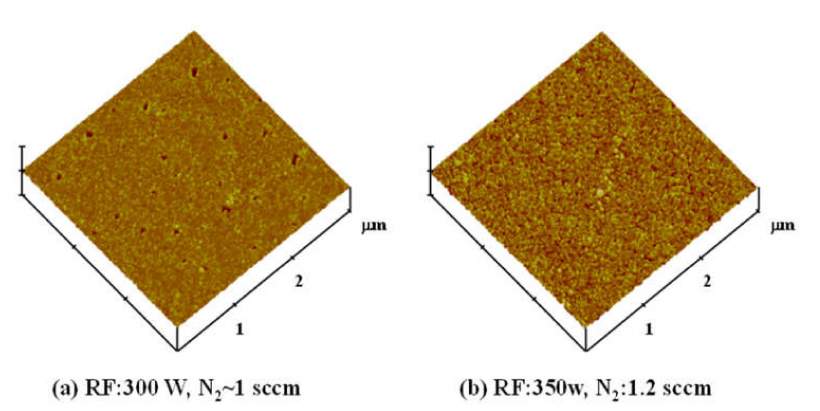
Figure 2. ( a ) Surface morphologies, refractive index, and extinction coefficient of nitrided Si x N y grown on Si(111) surface for 60 min with ( a ) RF: 300 W, N 2 : ~1 sccm, and ( b ) RF: 350 W, N 2 : ~1.2